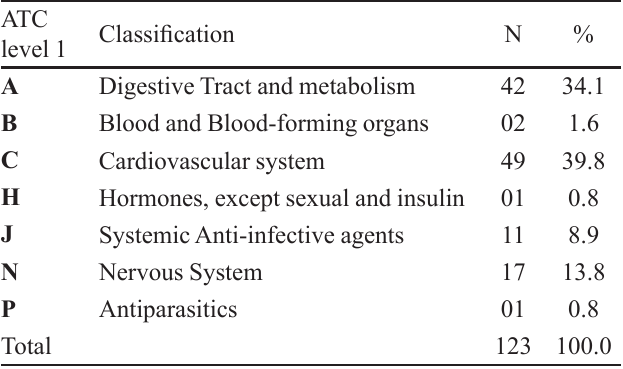
FIGURE 1 - Possible ADR found in the 65 patients studied. Campina Grande, 2010.